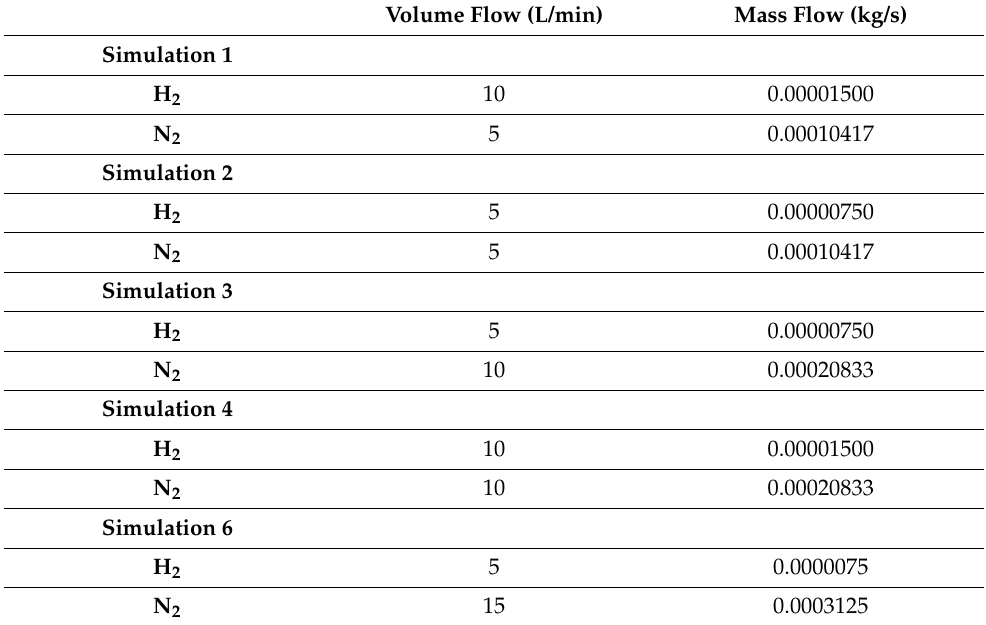
Table 2. Flows in different simulations.